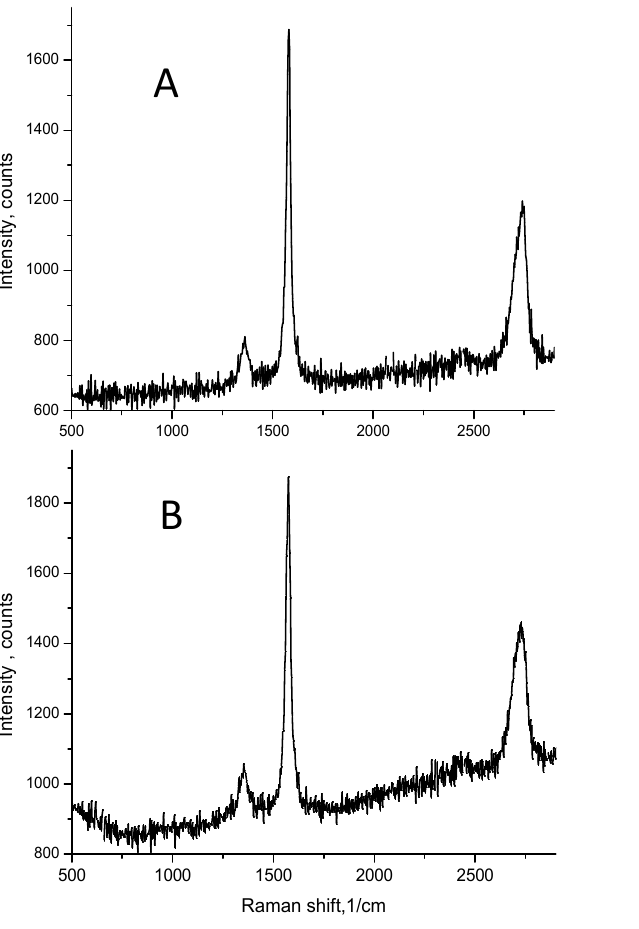
Figure 9. Raman spectra of the micrographite ( A ) and fabricated piezoresistive film ( B ), from 500 to 2800 cm − 1 .